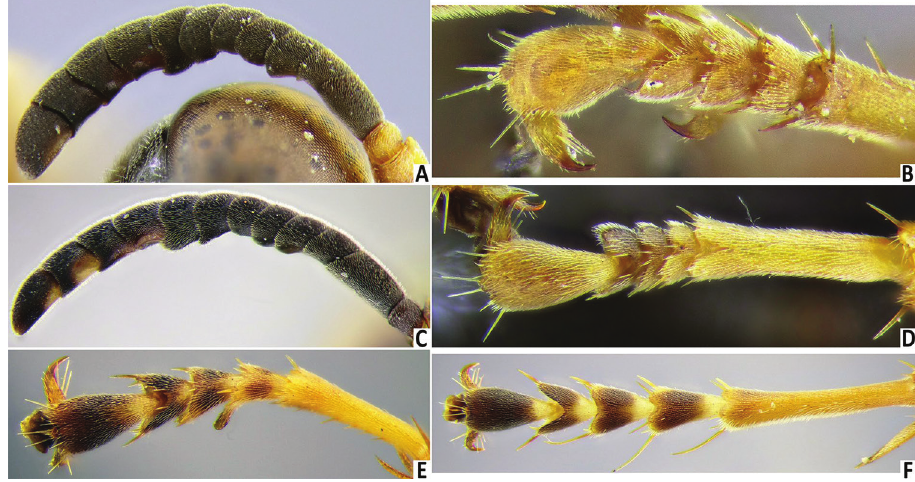
Figure 6. Hoplisoides gazagnairei (Handlirsch) from Tunisia [FSCV] ( A–B ), and H. distinguendus (Ya- sumatsu) from Buryatia, Russia [FSCV] ( C–F ), males: A , C antenna, dorsal view B , D foretarsus, dorsal view E midtarsus, dorsal view F hindtarsus, dorsal